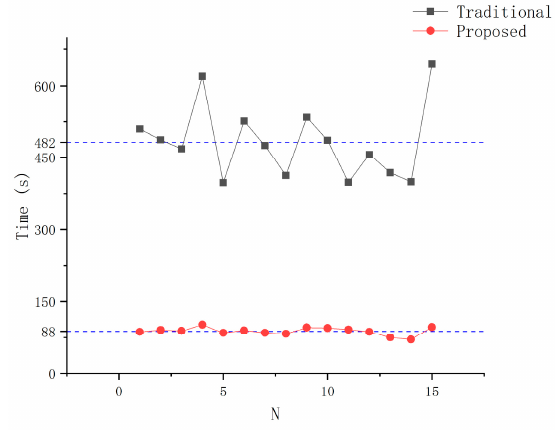
Figure 16. Time consumption.